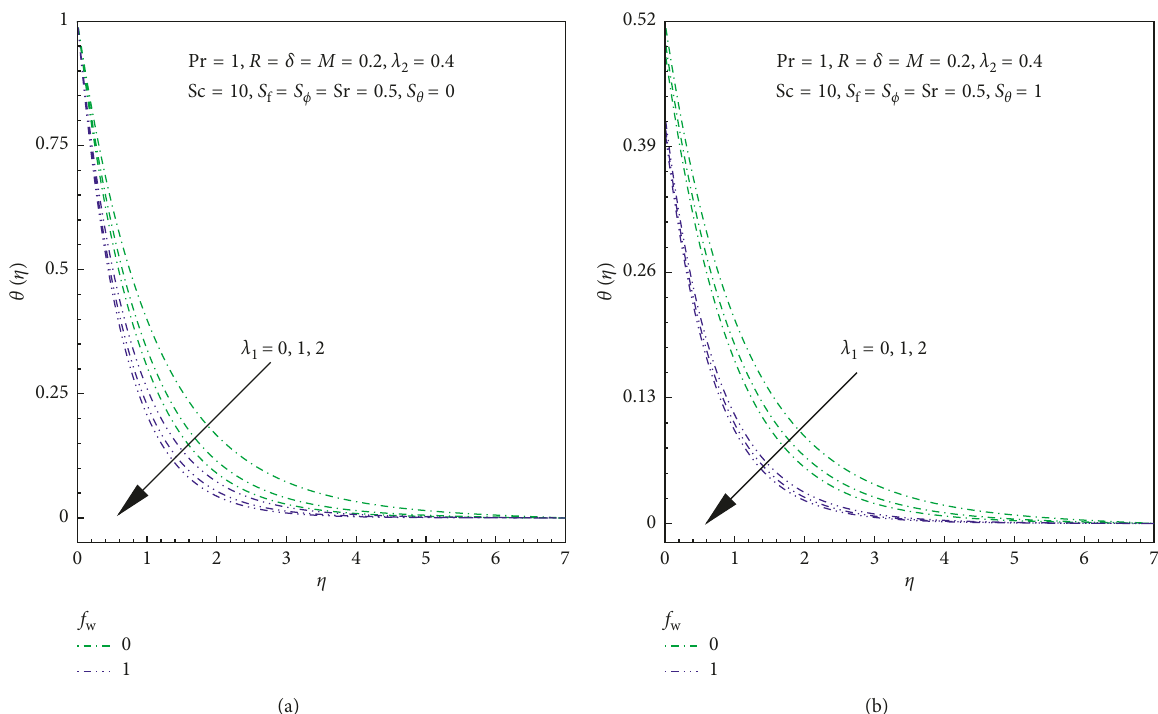
Figure 7: Effects of λ f 1 and w on dimensionless temperature. (a) No thermal slip. (b) With thermal